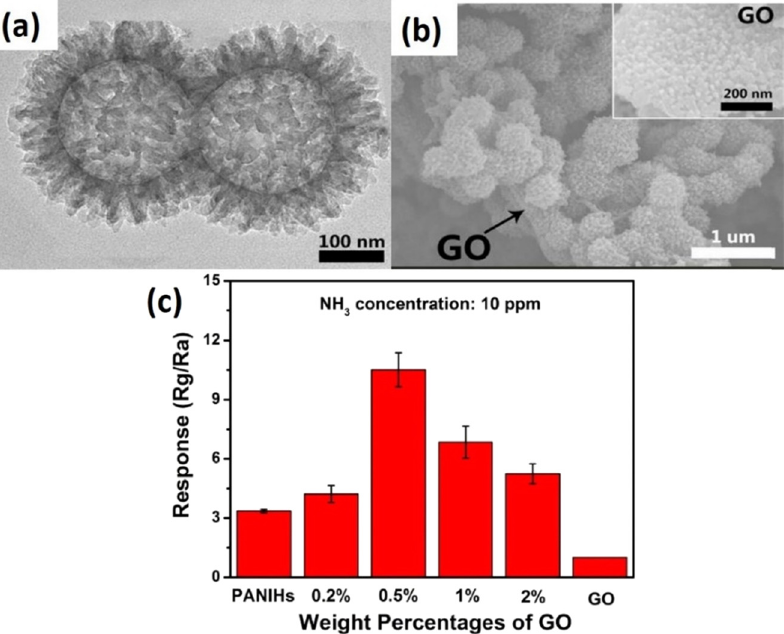
Figure 29: ( a and b ) TEM image of rambutan - like PANIHs and the nanocomposites, and ( c ) sensor response on the e ff ect of weight percentages of GO. Reproduced from ref. [ 188 ]